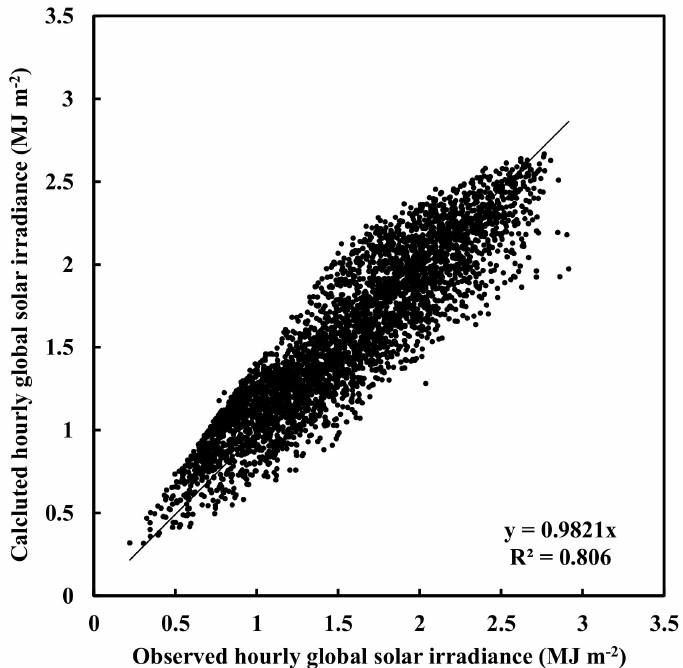
Figure 1. Scatter plot of calculated versus observed hourly global solar irradiance from 6:00 to 14:00 during April 2008–August 2011 under all sky conditions at Sodankylä (sample number n = 3962). There was a strong correlation between G and absorbing and scattering terms (R =